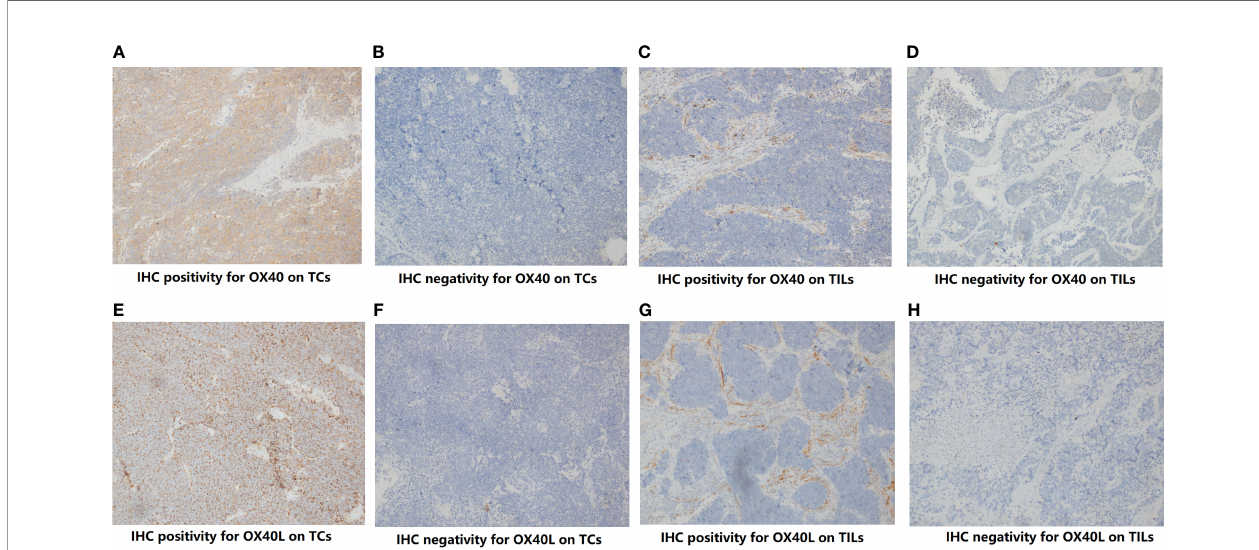
FIGURE 1 | The protein expression of OX40 and OX40 ligand (OX40L) on tumor cells (TCs) and In fi ltrating lypmphocytes (TILs). (A) IHC positivity for OX40 on TCs. (B) IHC negativity for OX40 on TCs. (C) IHC positivity for OX40 on TILs. (D) IHC negativity for OX40 on TILs. (E) IHC positivity for OX40L on TCs. (F) IHC negativity for OX40L on TCs. (G) IHC positivity for OX40L on TILs. (H) IHC negativity for OX40L on